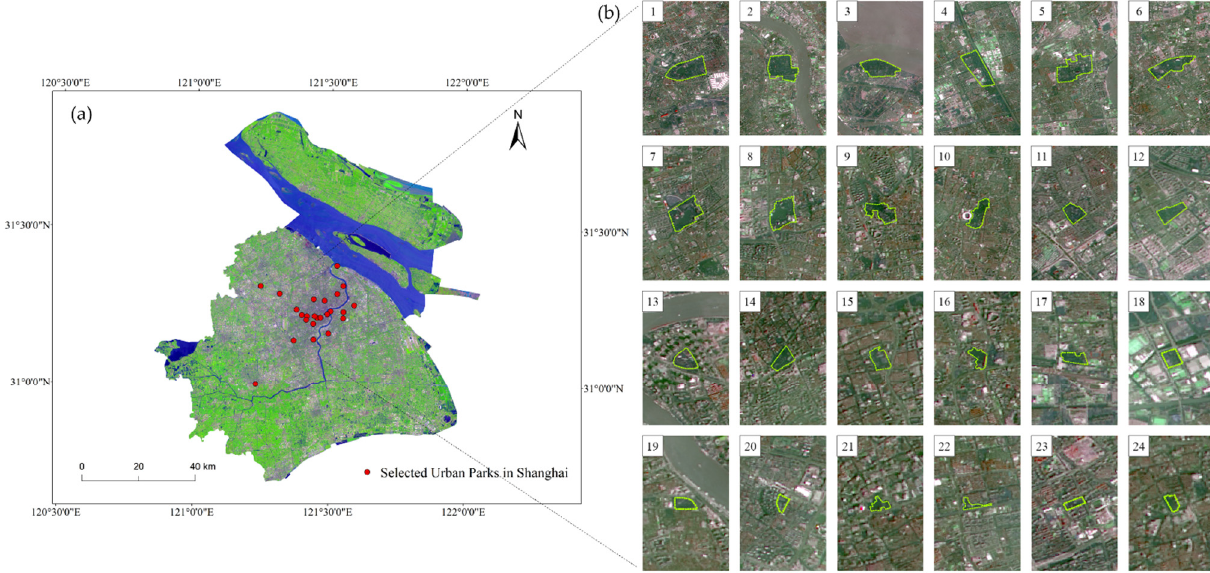
Figure 1. ( a ) The space distribution of selected urban parks in Shanghai. ( b ) The geometric features of the selected 24 parks and their surrounding environment. Natural true colors with RGB composition of band 4, 3 and 2, are fused with panchromatic band (band 8) to form an image base map with 15 m spatial resolution.